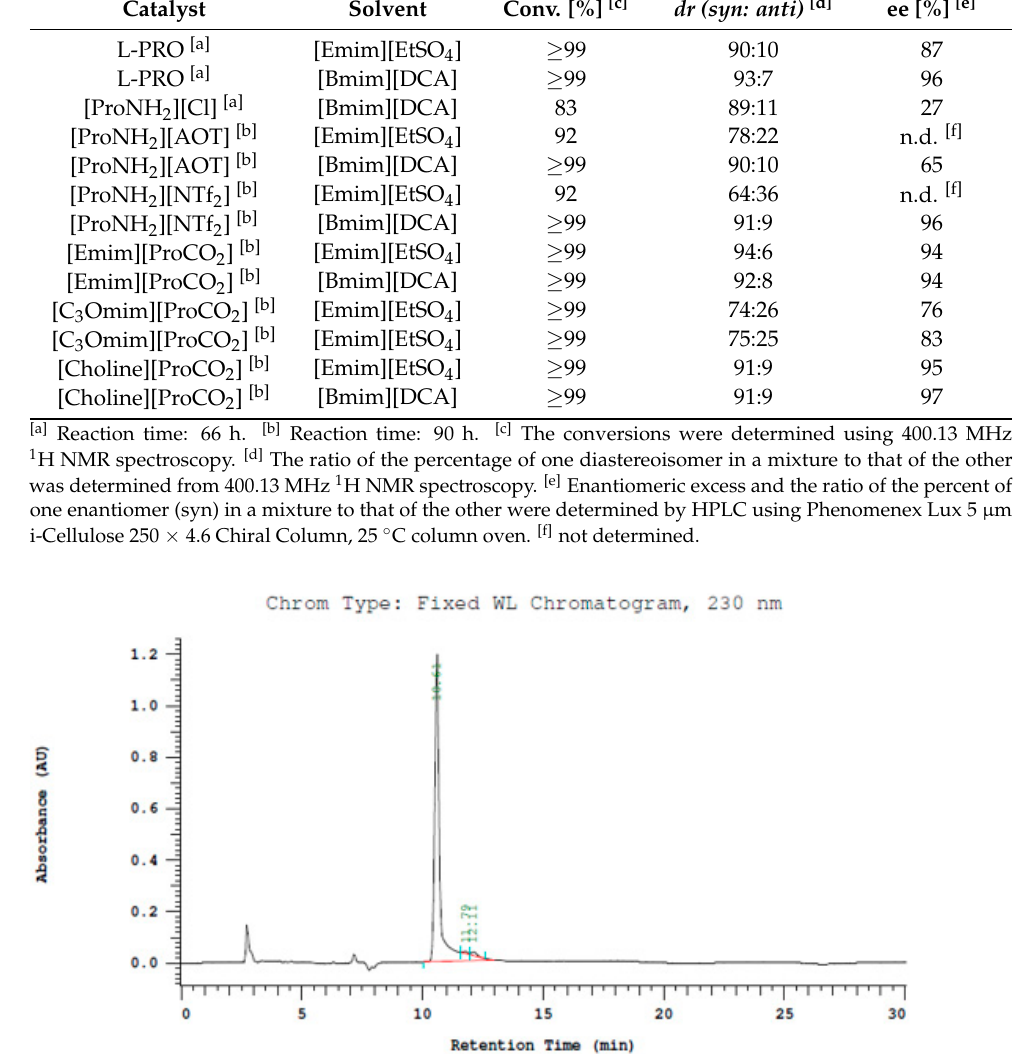
Table 3. Michael addition of cyclohexanone to trans-nitrostyrene catalyzed by CILs based on L-proline (30 mol%) using ILs as solvent. Catalyst